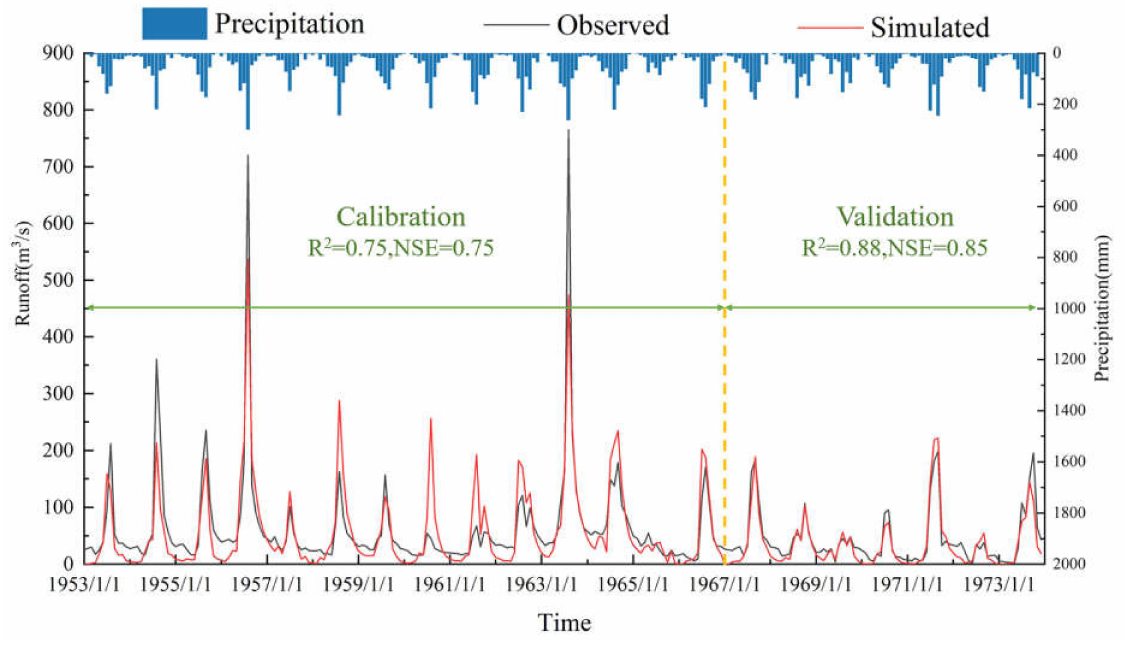
Figure 4. SWAT simulation result of Guantai station.